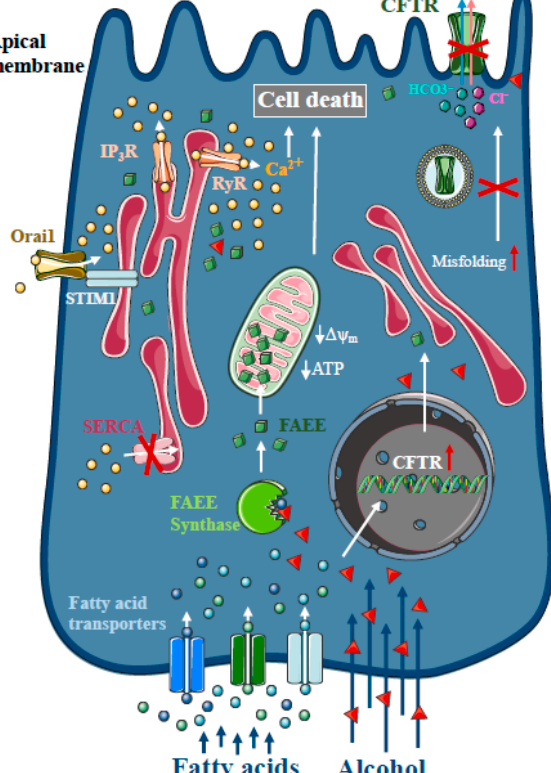
Figure 2. Intracellular Ca 2 + signalling in alcoholic acute pancreatitis. In the pancreas, non-oxidative ethanol metabolism is the dominant metabolic pathway mediated by enzymes with fatty acid ethyl ester (FAEE) synthase activity, which combine ethanol and fatty acids to generate FAEE. In pancreatic acinar cells, FAEEs are accumulated in the mitochondria and their local breakdown leads to localised high concentrations of fatty acids. Similar to bile acids, FAEEs induce sustained [Ca 2 + ] i elevation and drop of cellular ATP leading to necrosis. In addition, alcohol and fatty acids inhibit fluid and HCO 3- secretion in the pancreatic ductal epithelia, mainly due to the impaired expression and function of the cystic fibrosis transmembrane conductance regulator (CFTR).